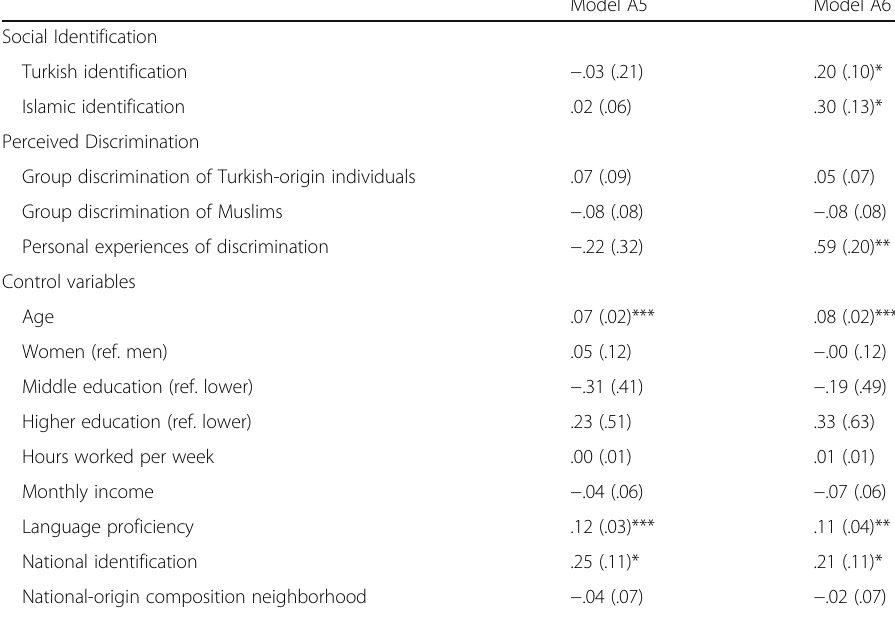
Table 11 Binary logistic regression: Interplay between social identifications, personal discrimination and local voting